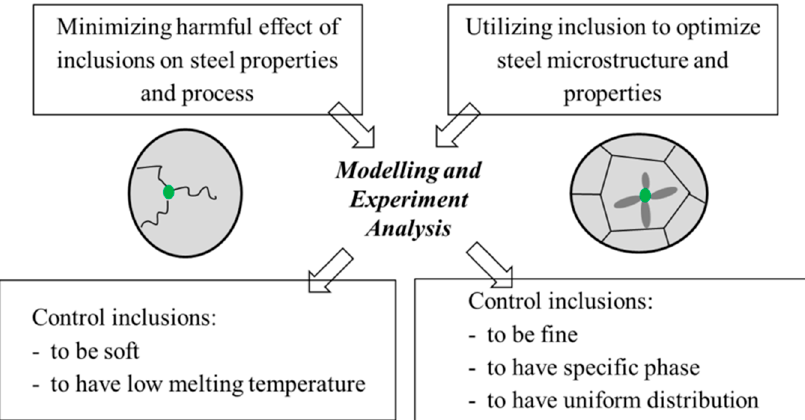
Figure 1. Concept of inclusion engineering [5].